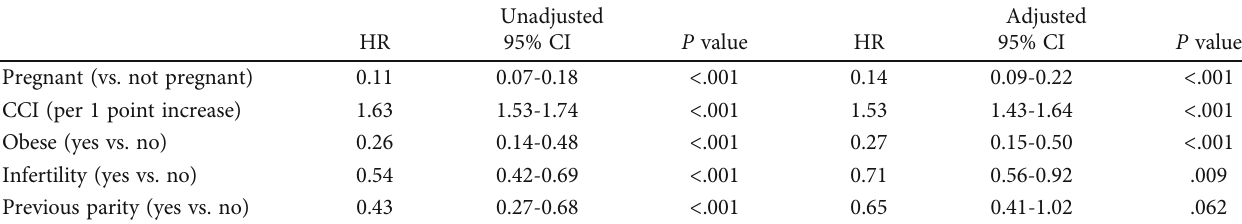
Table 2: Cox proportional hazard regression analysis for the outcome of a liver-related event during follow-up.